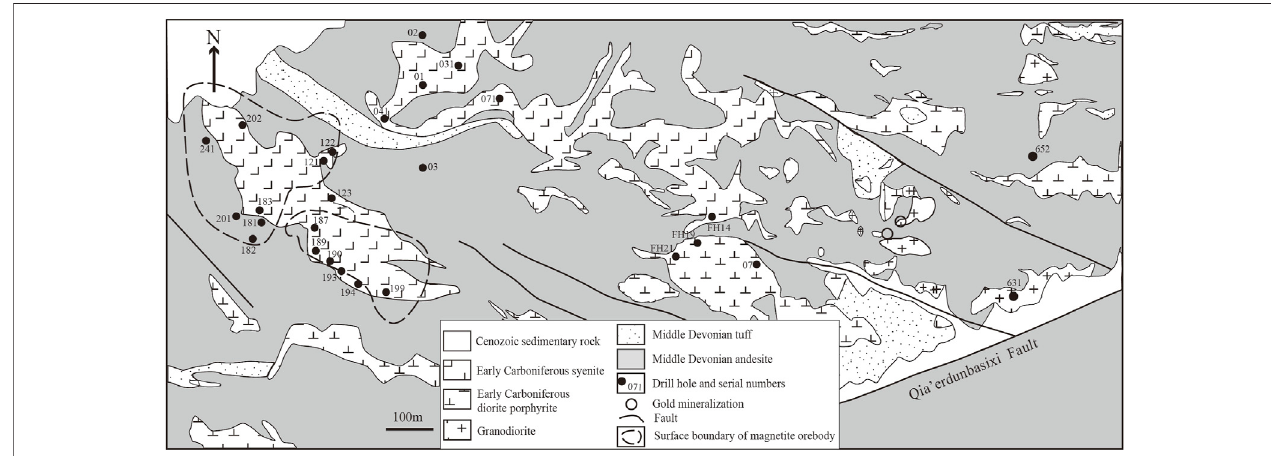
FIGURE 2 | Geological map of the Qia ’ erdunbasixi deposit (modi fi ed after Wang and Zhu, 2010 and Xia et al., 2022).